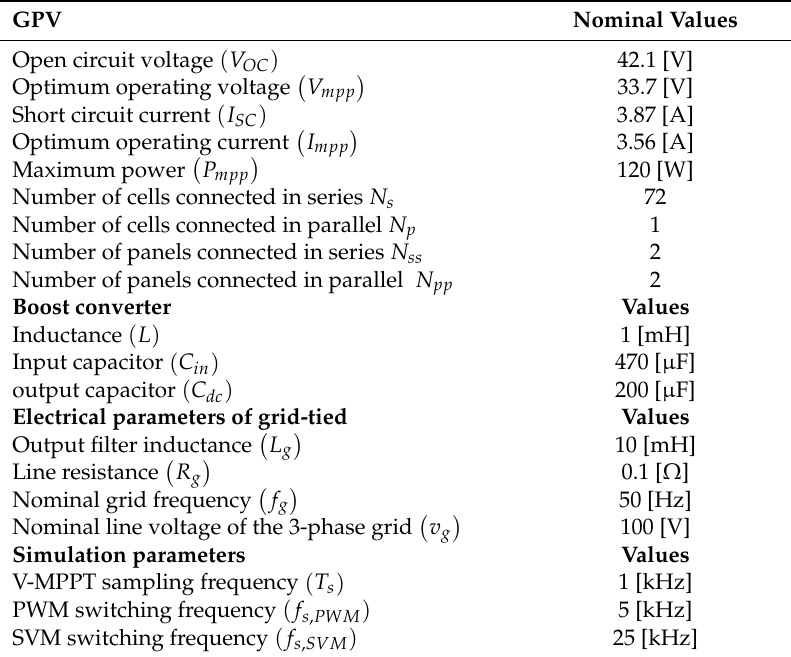
Table A1. Global system